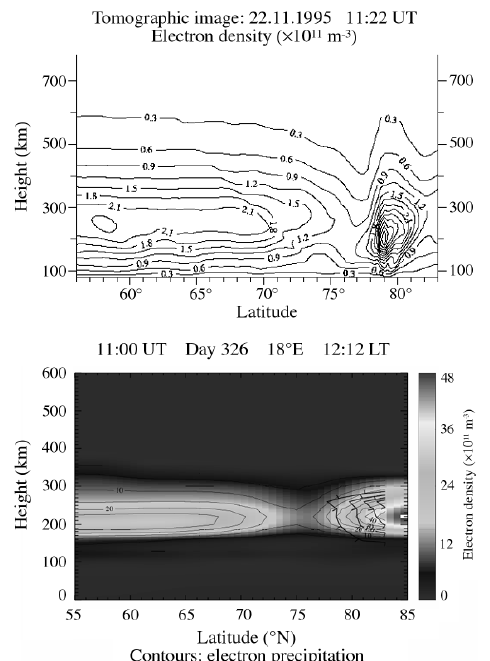
Fig. 11. Tomographic image from experimental ob- servations in Scandinavia with corresponding output from the SUPIM model. From Idenden et al. (1998), reproduced by permission of Annales Geophysicae